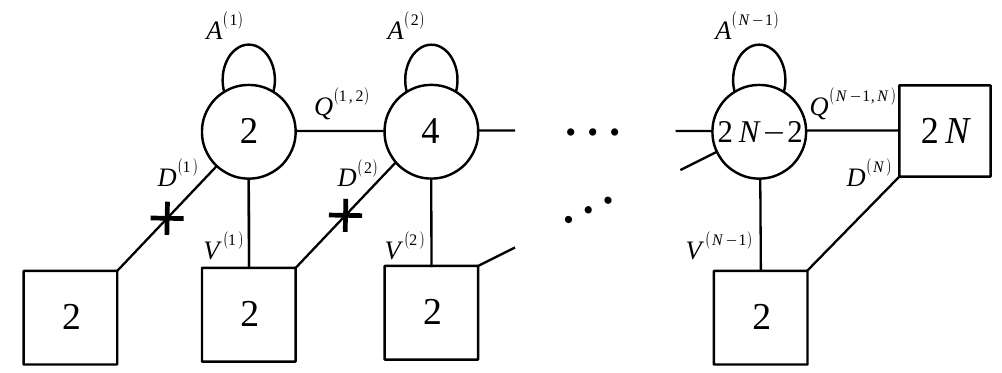
Figure 12 . Quiver diagram for E [USp(2 N )]. Round nodes denote gauge symmetries and square nodes denote global symmetries. Single lines denote chiral (cid:12)elds in representations of the nodes they are connecting. In particular, lines between adjacent nodes denote a chiral (cid:12)eld in the bifundamental representation of the two nodes symmetries, while arcs denote chiral (cid:12)elds in the antisymmetric representation of the corresponding node symmetry. Crosses represent the singlets (cid:12) n that (cid:13)ip the diagonal